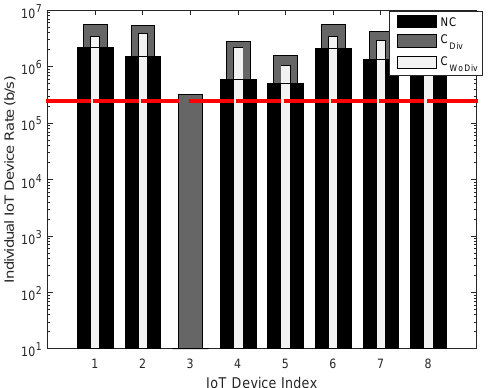
Figure 8. Individual device achieved data rate with respect to different number of total devices, with two relays and minimum device data rate of 250 kbps.